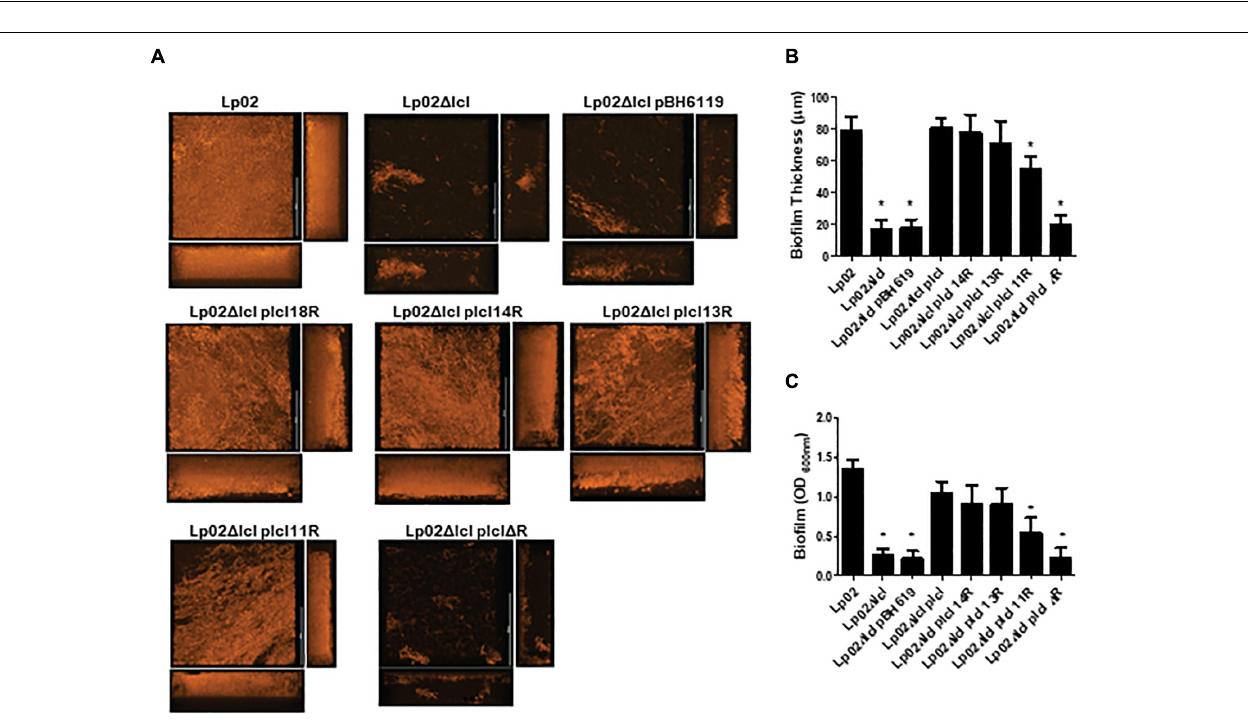
FIGURE 7 | Increased number of repeats in the R domain promote stronger binding of L. pneumophila to surfaces. (A,B) The binding of the indicated L. pneumophila strains measured by RT-qPCR after 1 h of attachment to polystyrene 96-well plates (A) or 96-well plates coated fucoidan (B) . ∗ denotes p < 0.05 by one-way ANOVA. Experiments were performed in